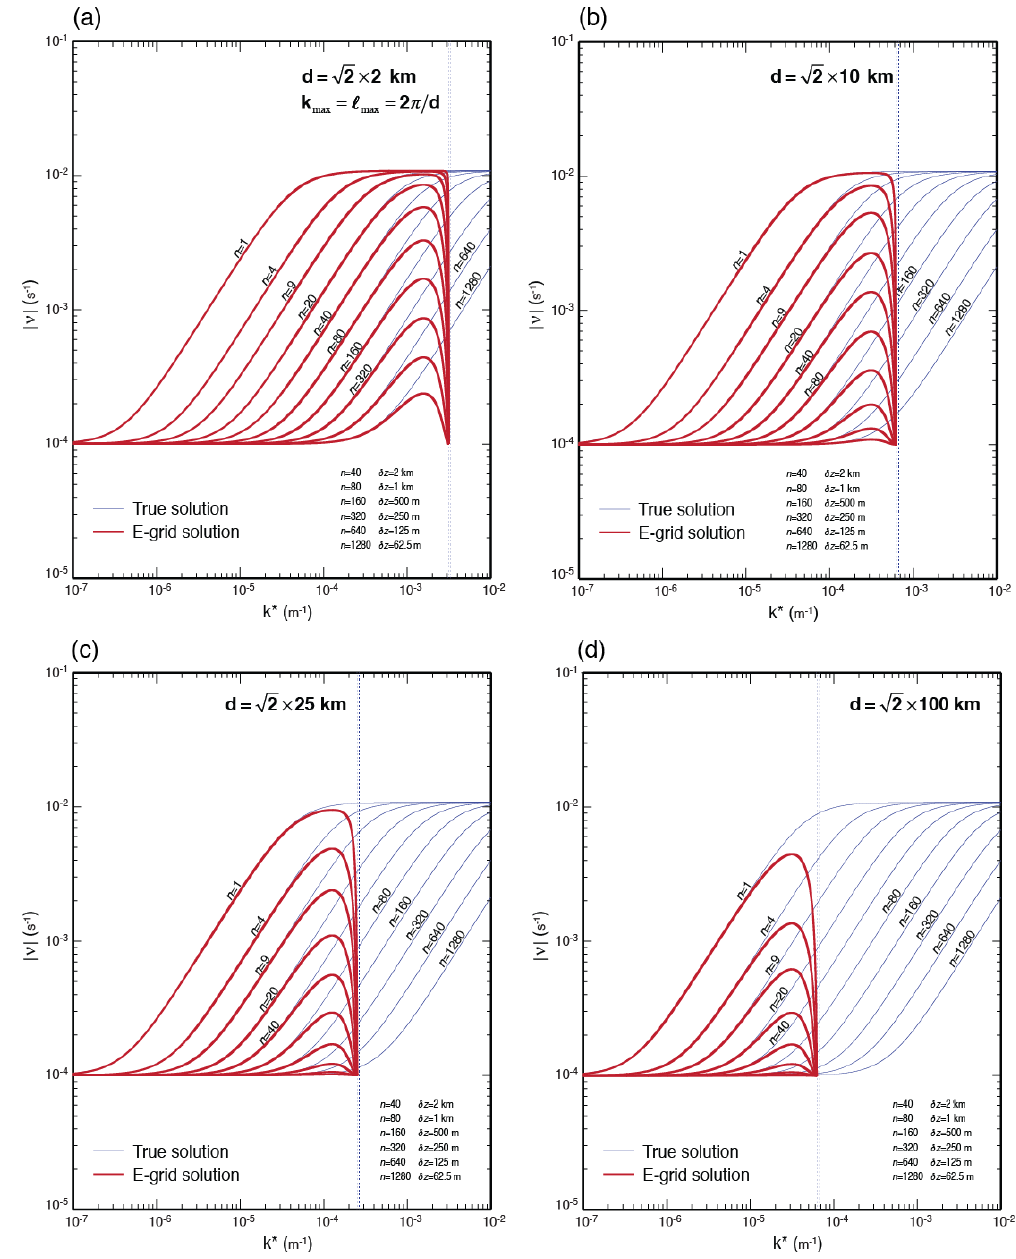
Figure 8. Same as Fig. 2 but for the E